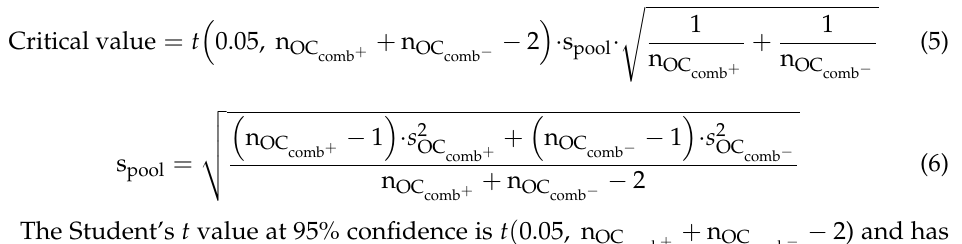
The FI is significant when the Critical values are calculated by Equation (5) and the pooled standard deviation ( s pool ) by Equation (6)